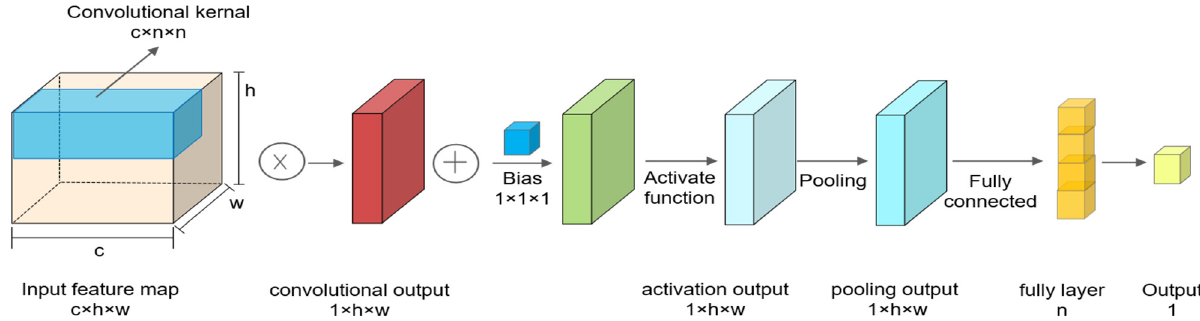
Figure 4. The basic CNN structure. The “ × ” and “+” with circles are multiplication and addition operations.